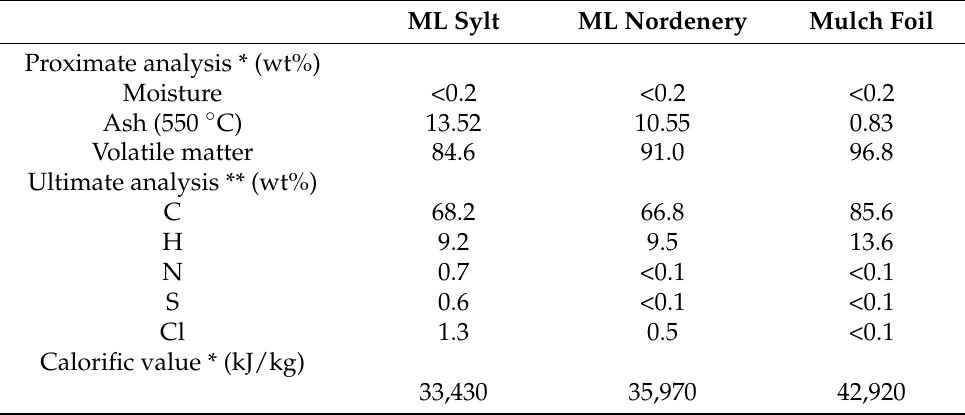
Table 4. Characteristics of ML fractions and mulch foils (as received) (* n = 2; ** n = 3). ML Sylt ML Nordenery Mulch